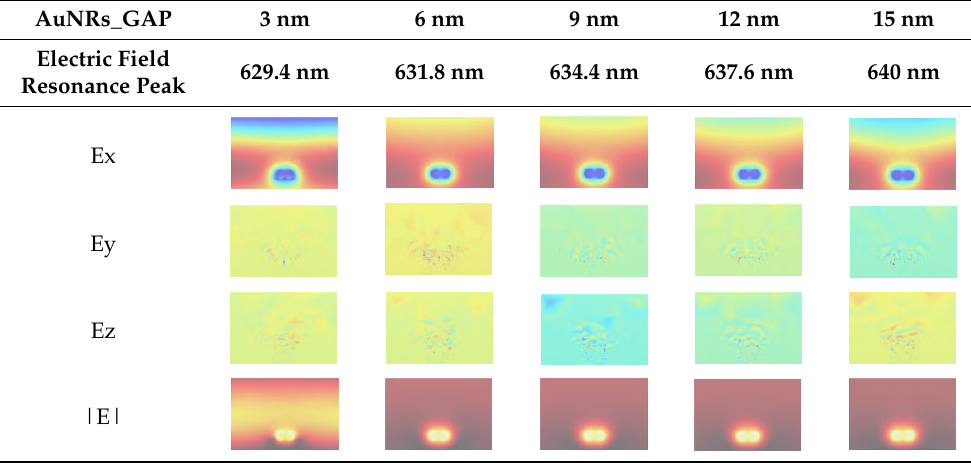
Table 1. Electric field distribution under the resonance peak of the gold nanorod dimer in the juxtaposed structure (Y-Z section).